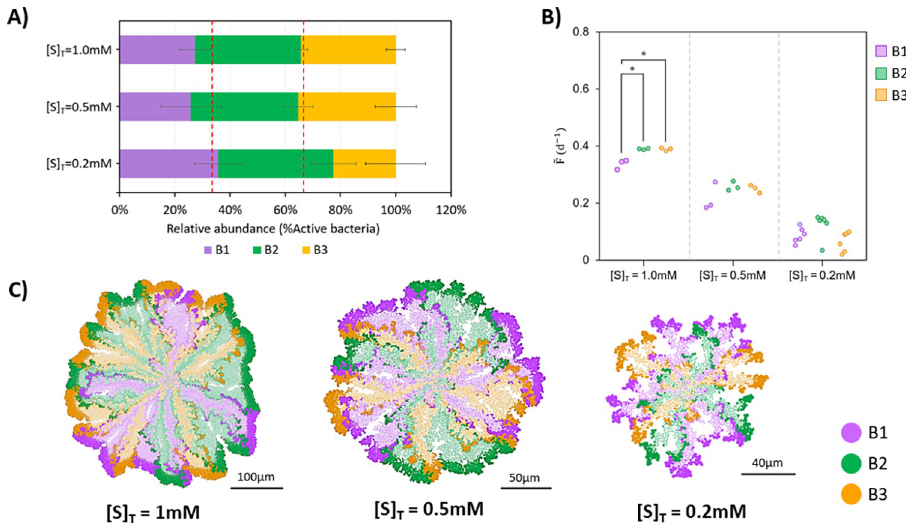
Fig 3. Neutralism [0,0,0]. (A) Relative abundances of B1, B2 and B3 populations in the community. Dashed red lines indicate 33.33% and 66.66% relative abundances. (B) Microbial fitness (median, ~ F ~ ) is calculated in all replicates ( n = 3 for 1.0 mM and 0.5 mM, n = 6 for 0.2 mM). Asterisks indicate the significance level of the difference between B1, B2 and B3 specific growth rate. (C) Aggregates captured at steady state (75 d for 1.0 mM and 0.5 mM, 100 d for 0.2 mM). Inactive bacteria are shown in a lighter colour. Black solid lines on bottom represent the scale bars. Significance level legend: ns, not significant; � , p < 0.05; �� , p < 0.01; ��� , p <